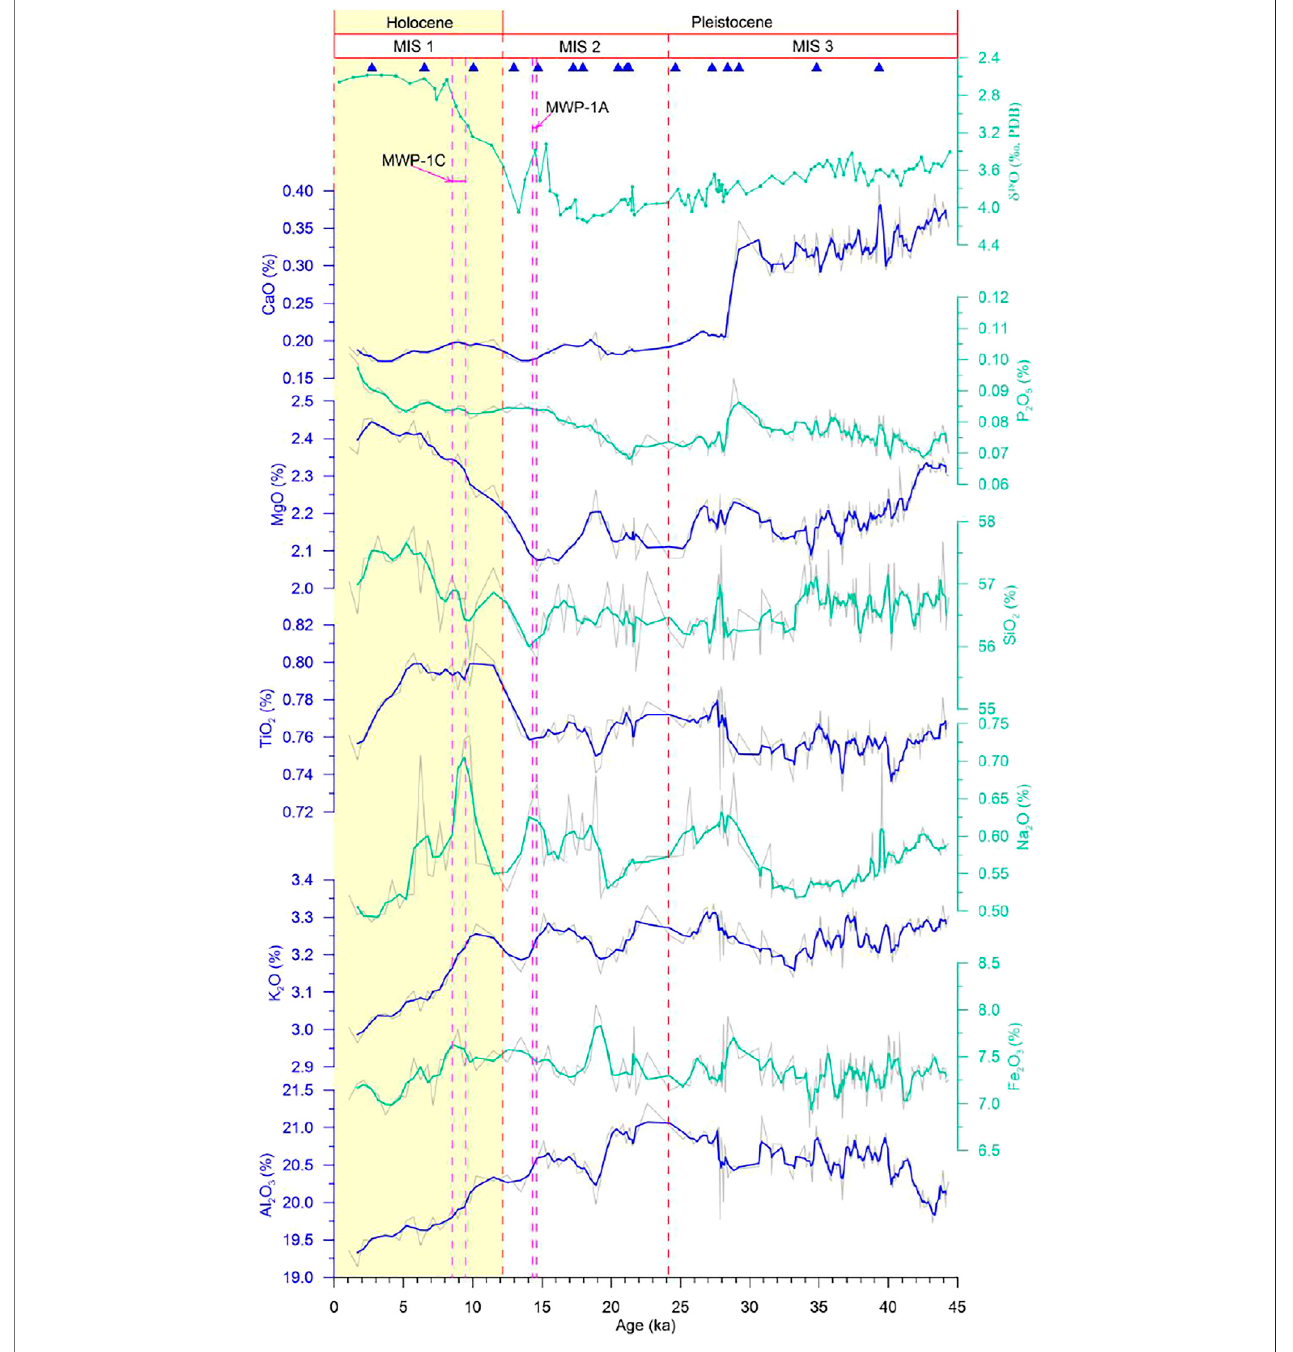
FIGURE 4 | Temporal variations of major elements of Core MD05-2896 over the last 45 ka. The benthic foraminiferal C. wuellerstor fi δ 18 O stratigraphy and foraminiferal AMS 14 C datings (blue triangle) (Wan and Jian, 2014; Wan et al., 2020) are also displayed. Dashed magenta lines indicate the meltwater pulses 1A (MWP- 1A) (Hanebuth et al., 2000) and 1C (MWP-1C) (Tjallingii et al., 2010). The major element data were smoothed by a three-point running average (coarse).